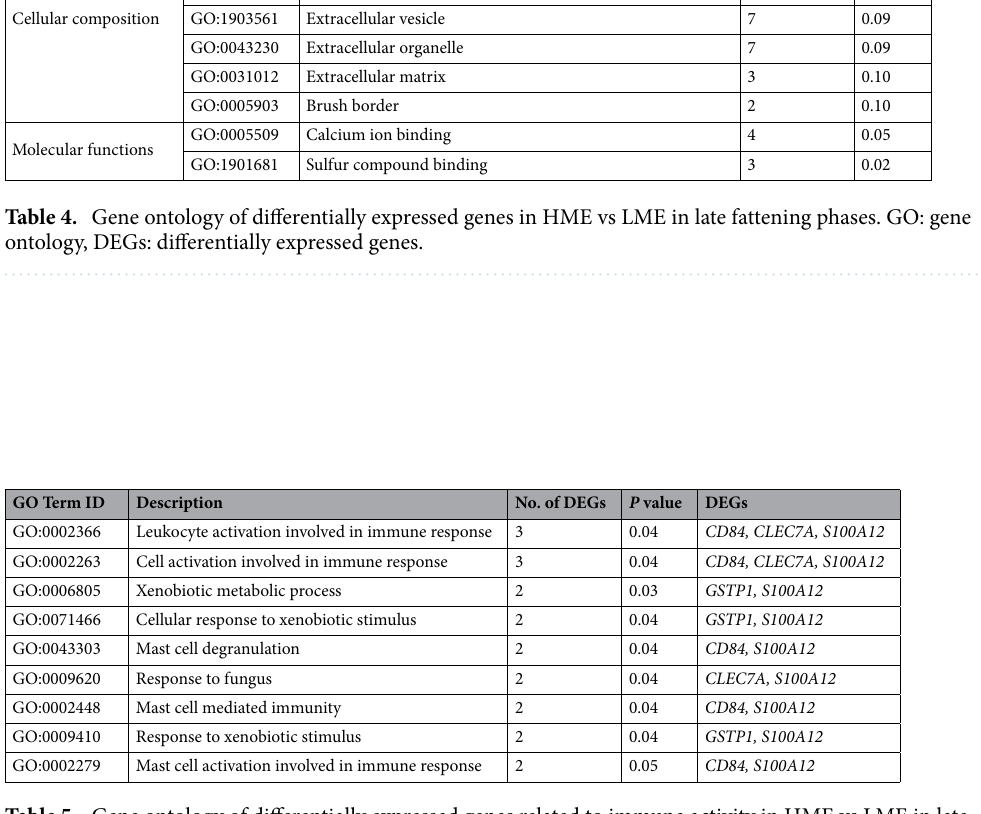
Table 5. Gene ontology of differentially expressed genes related to immune activity in HME vs LME in late fattening phases. GO: gene ontology, DEGs: differentially expressed